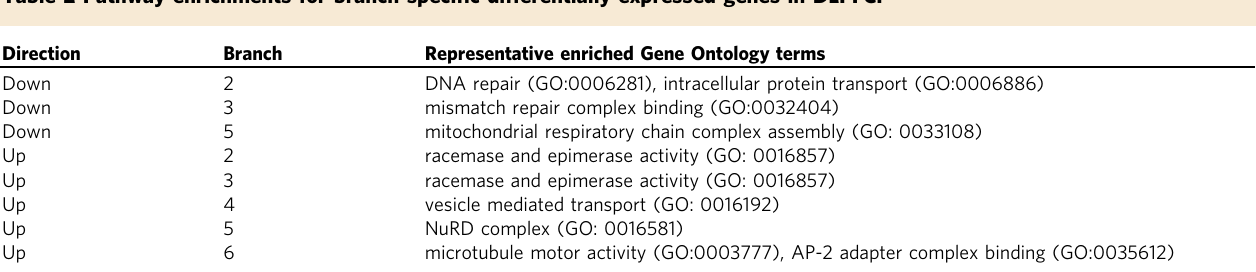
Table 2 Pathway enrichments for branch-speci fi c differentially expressed genes in DLPFC.